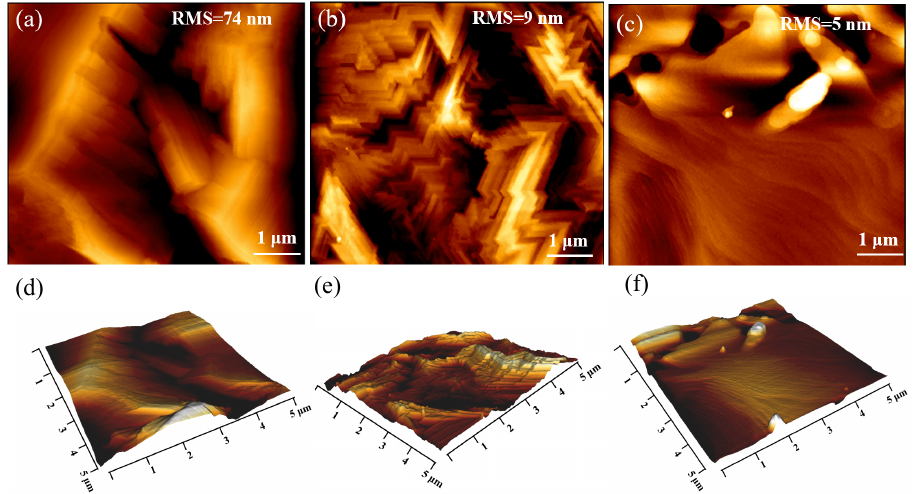
Figure 11. The 2D ( a ) and 3D ( d ) AFM result of β -Ga 2 O 3 thick film grown directly on sapphire substrate. The 2D and 3D AFM results of β -Ga 2 O 3 thick film grown on β -(Al x Ga 1 − x ) 2 O 3 /sapphire substrate by carbothermal reduction ( b , e ) and HVPE ( c , f